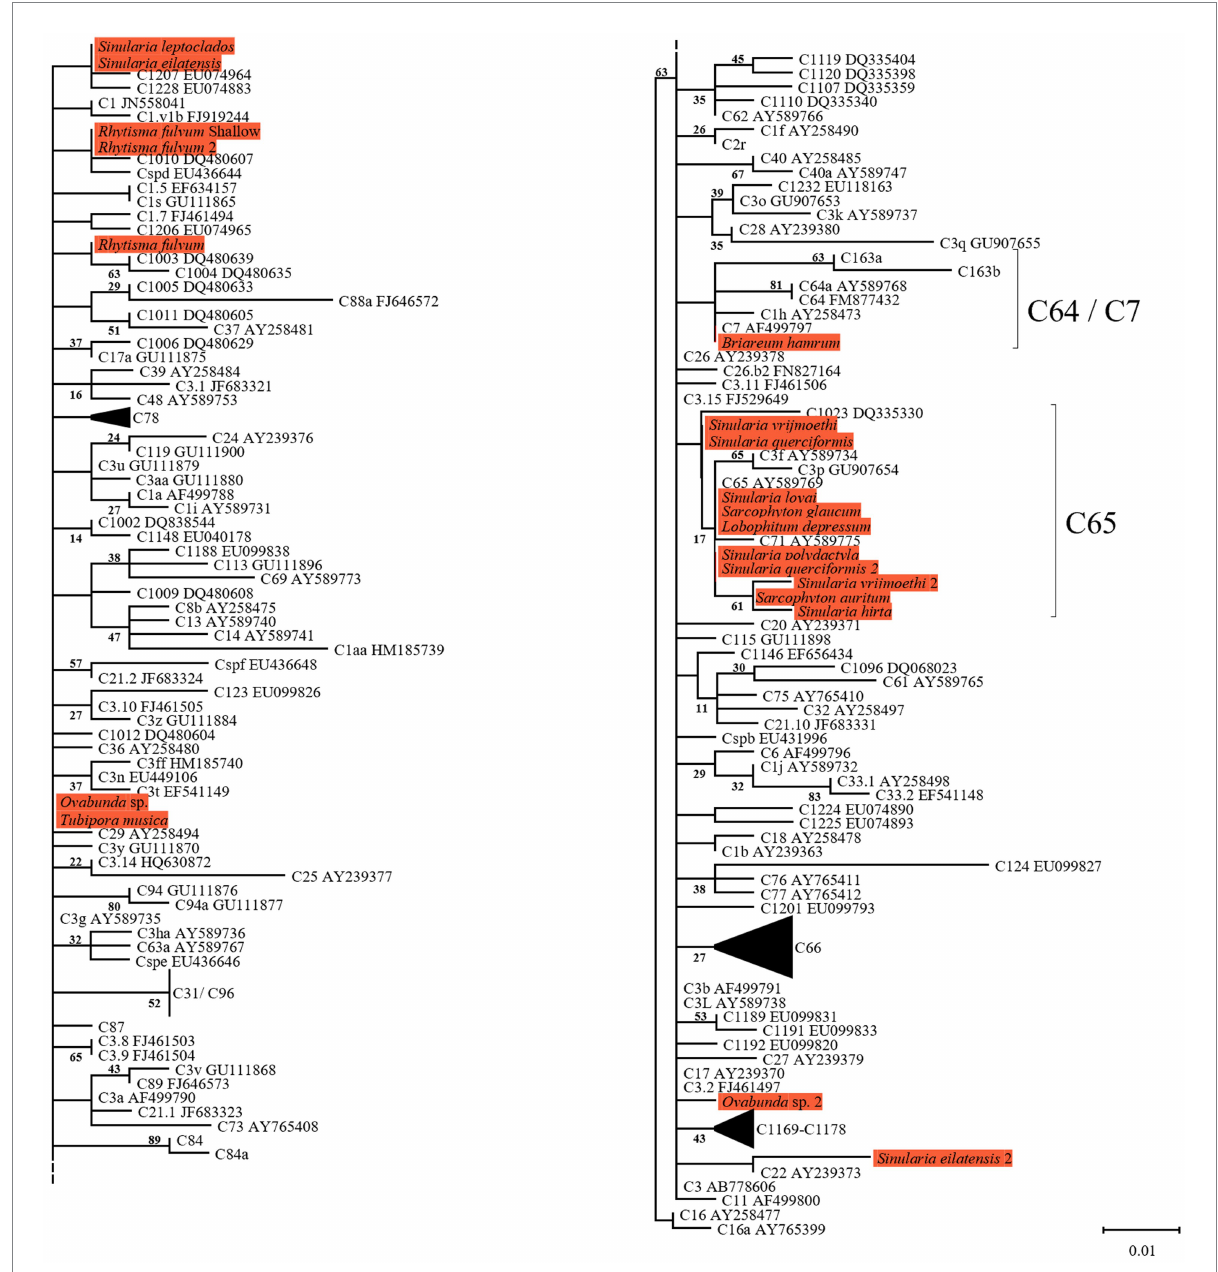
FIGURE 3 Right and Left; Phylogenetic relationship of the genus Cladocopium (previously named clade C) based on ITS2 rDNA sequences (270 bp), under the HKY + F model. The maximum likelihood tree was reconstructed with IQ-TREE 2.1.3. ML bootstrap supports based on 1,000 replicates are indicated either above or below the corresponding branch. Orange color indicates new Symbiodiniaceae sequences that were obtained in the current study for which the host name is indicated rather than the algal genetic type. Species that presented a variation in the obtained sequence are indicated by the number